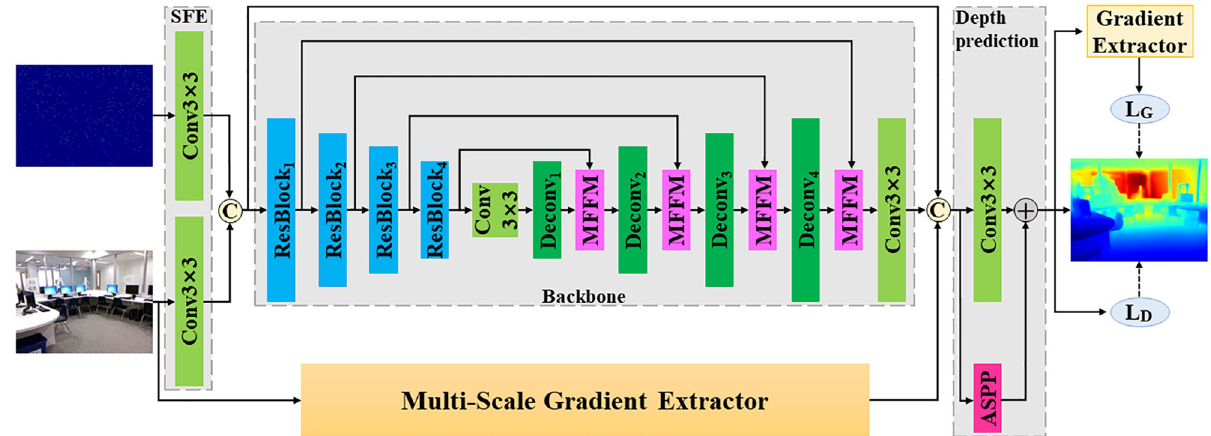
Fig 1. The overall architecture of the proposed SPNet. SFE represents shallow feature extractor. MFFM denotes the proposed multi-level feature fusion module. L and L represent the depth loss and gradient MAE loss ( L D G